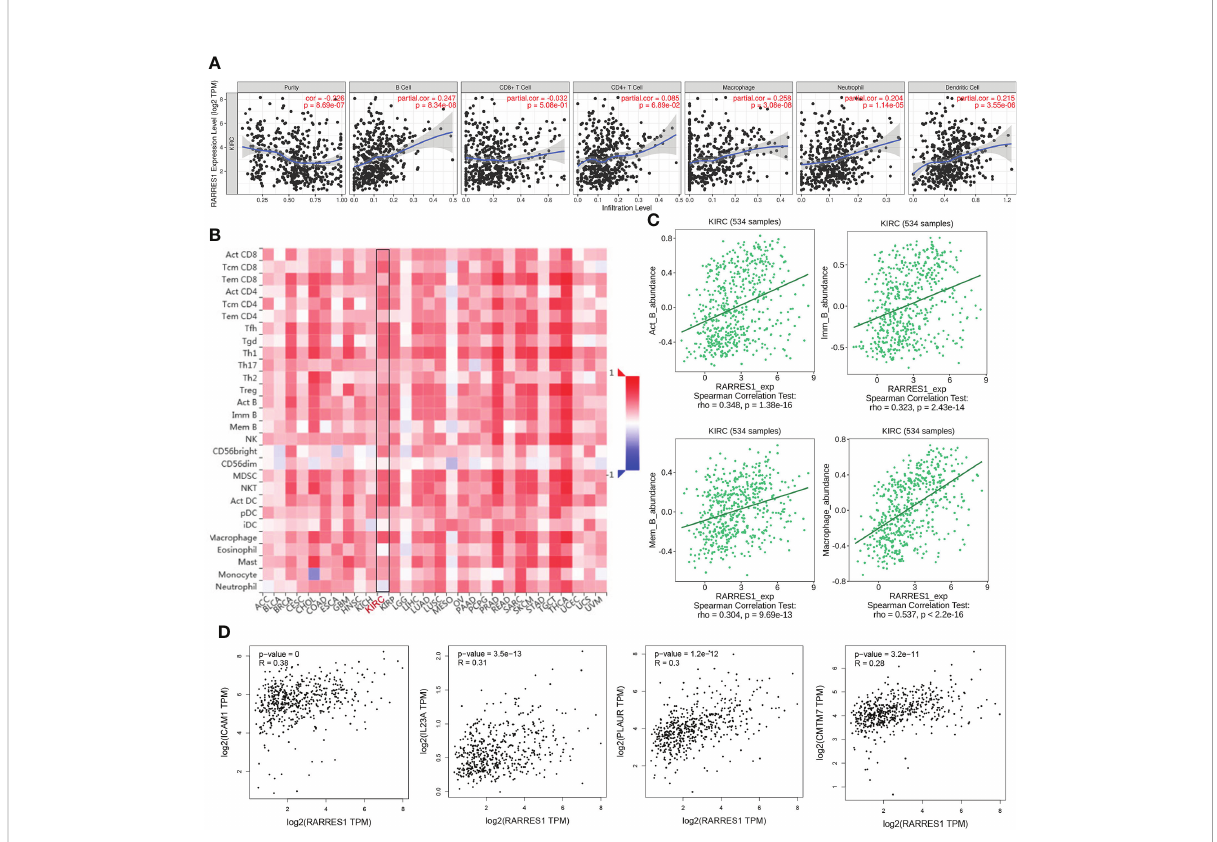
FIGURE 4 Analysis of associations between immune in fi ltration and the expression of RARRES1 and the 8 hub genes in KIRC. (A) Correlation of RARRES1 expression with the numbers of 6 tumor-in fi ltrating immune cells in KIRC using TIMER. (B) Relations between the expression of RARRES1 and the abundance of 28 types of TILs across heterogeneous human cancers. (C) RARRES1 expression was signi fi cantly correlated with the abundance of activated B cells (Act_B cells; rho=0.348, p<0.001), immature B cells (Imm_B cells; rho=0.323, p<0.001), memory B cells (Mem_B cells; rho=0.304, p<0.001), and macrophages (rho=0.537, p<0.001). (D) Correlations between the mRNA expression level of RARRES1 and those of CMTM7, PLAUR, IL23A, and ICAM1 in KIRC were determined using GEPIA.